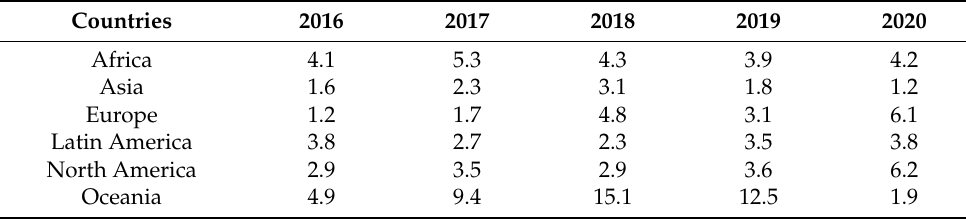
Table 9. The prices on the voluntary market.